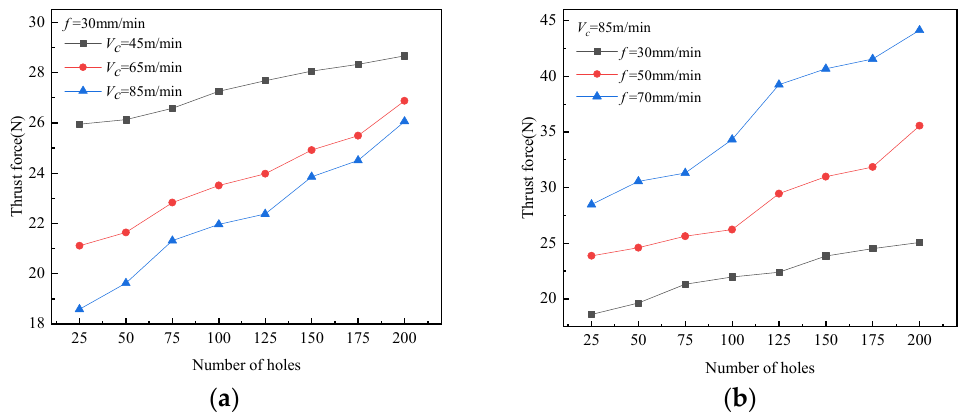
Figure 10. Effect of tool wear on the thrust force: ( a ) different cutting speeds; ( b ) different feed rates.